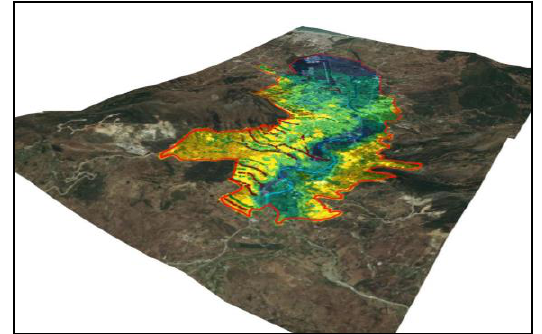
Figure 5 : RF Model with 3d representation